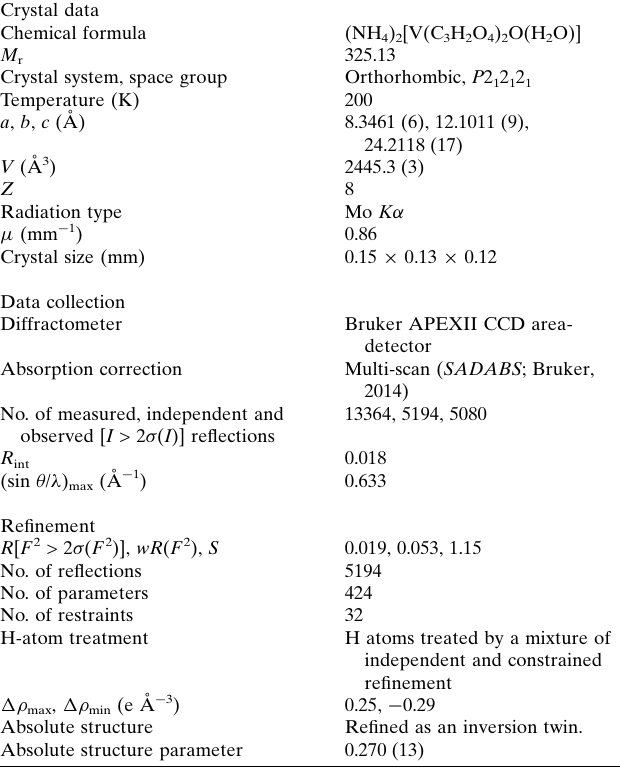
Table 2 Experimental details. Crystal data Chemical